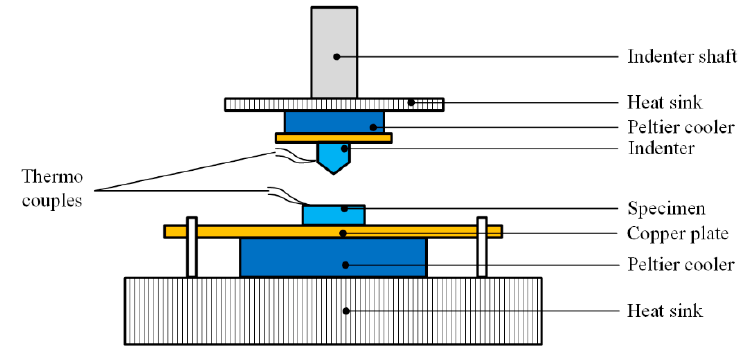
Figure 9. Schematic diagram of depth-sensing indentation (DSI) apparatus with Peltier cooler.